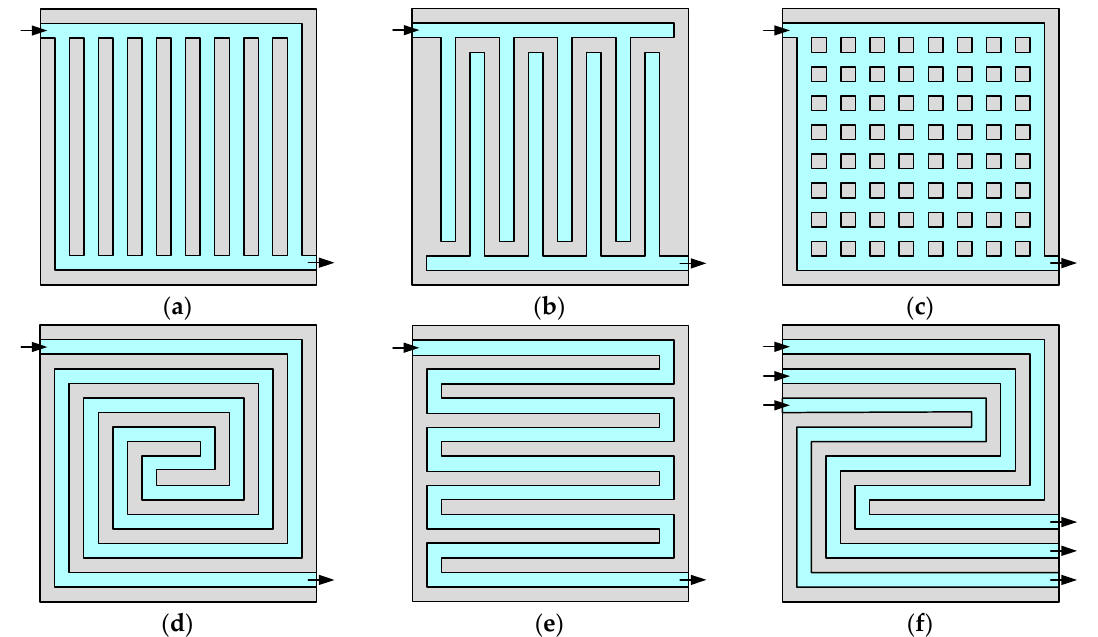
Figure 2. Scheme of typical flow field configurations: ( a ) straight parallel; ( b ) interdigitated; ( c ) pin-type; ( d ) spiral; ( e ) single-channel serpentine; ( f ) multiple-channel (triple) serpentine.